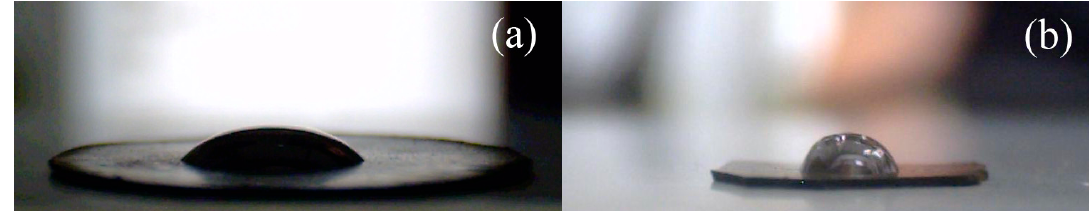
Figure 4. Contact angle measurements of the sessile drop of distilled water; ( a ) neat GO and ( b ) GO-PBMA.